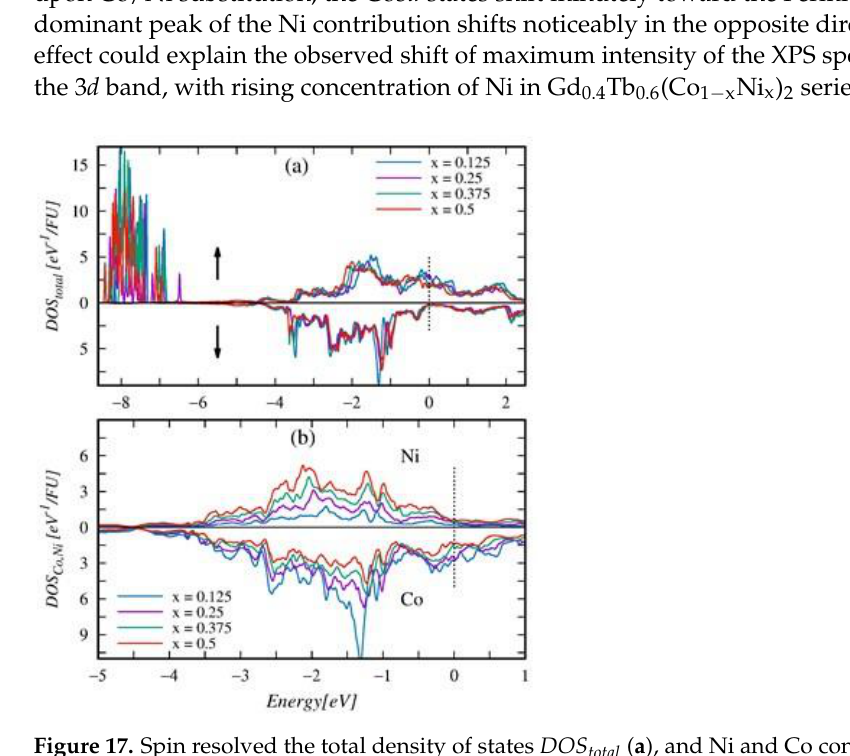
Figure 17. Spin resolved the total density of states DOS total ( a ), and Ni and Co contributions to the DOS ( b ) in the Gd 0.4 Tb 0.6 (Co 1 − x Ni x ) 2 series. For a detailed description, see the caption of Figure DOS ( b ) in the Gd 0 . 4 Tb 0 . 6 (Co 1−x Ni x ) 2 series. For a detailed description, see the caption of Figure 16.